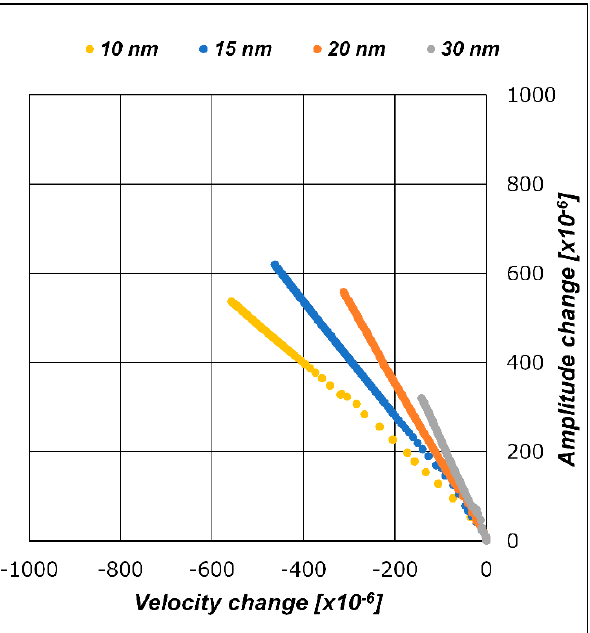
Figure 12. Layer parameter change with gold nanoparticle diameters (CRP concentration: 30 µ g/mL). Table 4. Calculated regression line slopes. Loaded Molecule